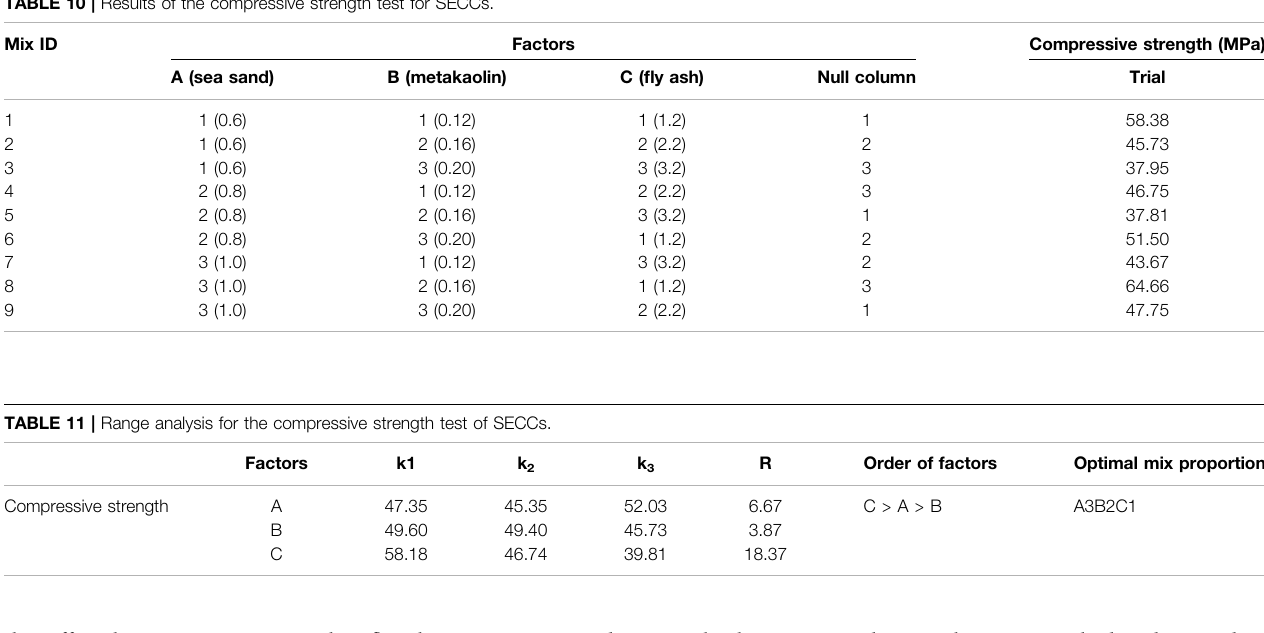
TABLE 10 | Results of the compressive strength test for SECCs.